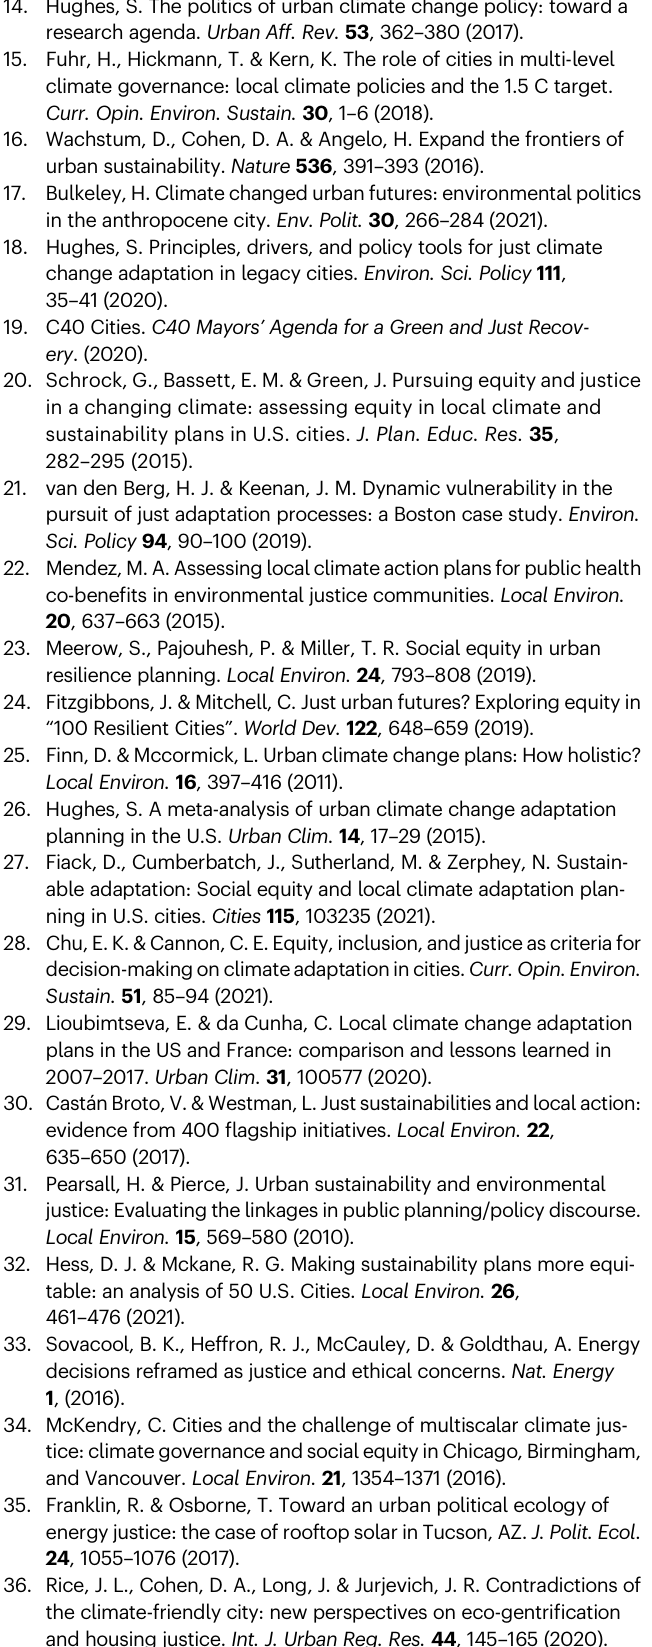
table: an analysis of 50 U.S. Cities. Local Environ. 26